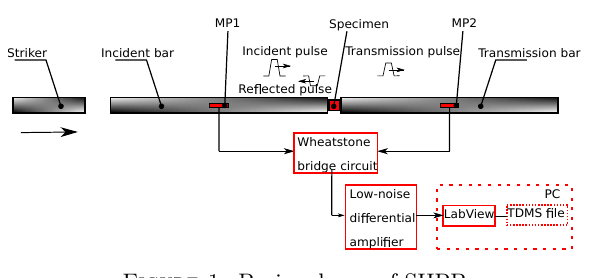
Figure 1. Basic scheme of SHPB